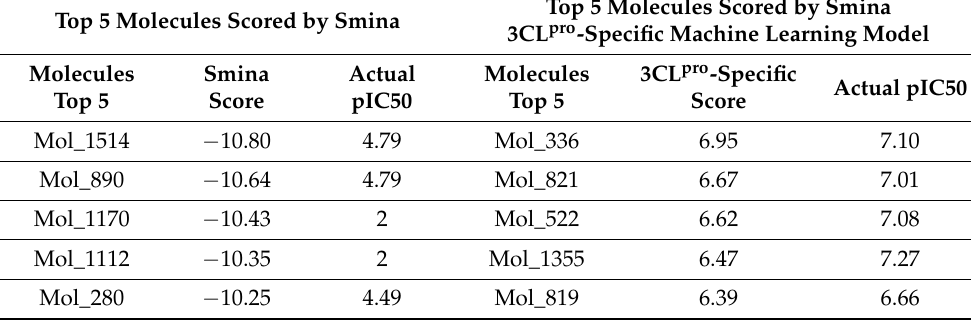
Table 1. Comparison of top 5 molecules ranked by Smina and our developed scoring function. Top 5 Molecules Scored by Smina